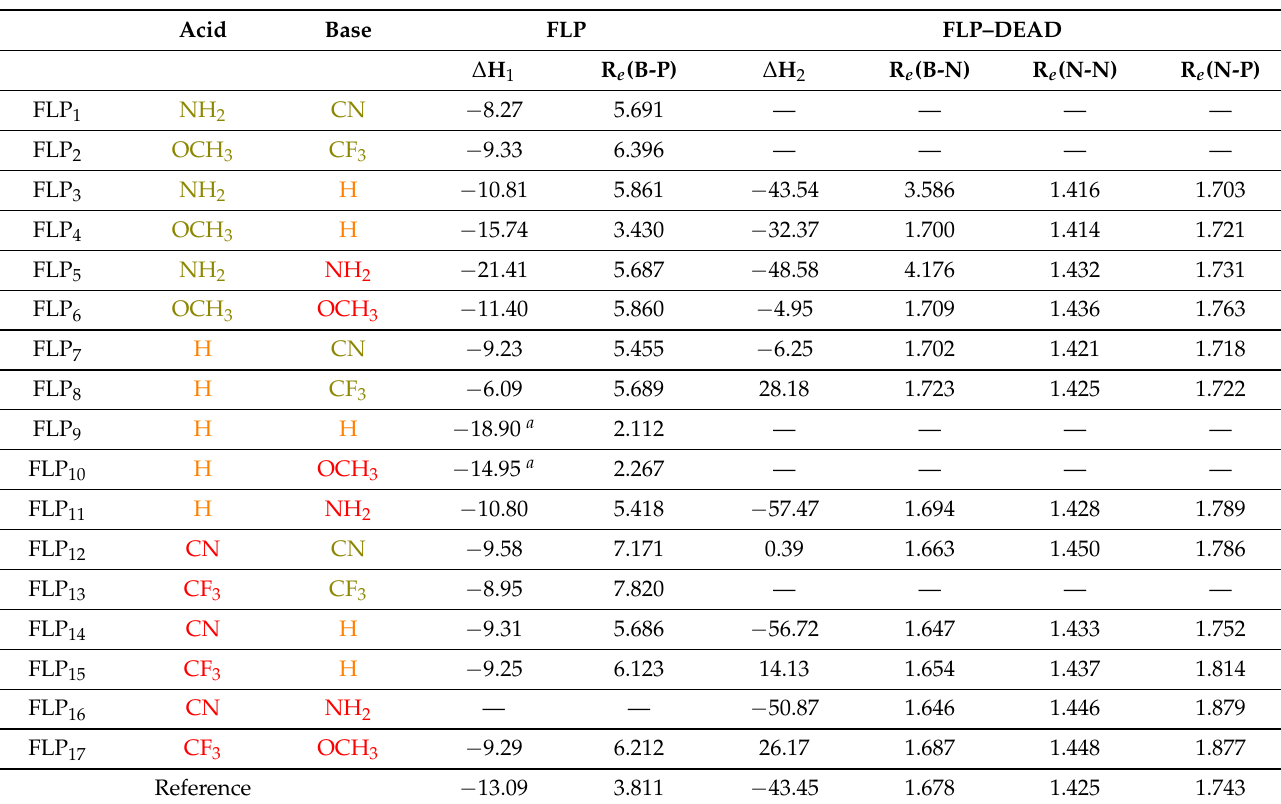
Table 2. Interaction energies between Lewis acids and bases to form the FLPs ( ∆ H 1 ) and between the FLPs and DEAD molecule ( ∆ H 2 ), in kcal/mol. Bond distances (R e ), in Å. Red, orange and green groups stand for strong, moderate and weak acids or bases,